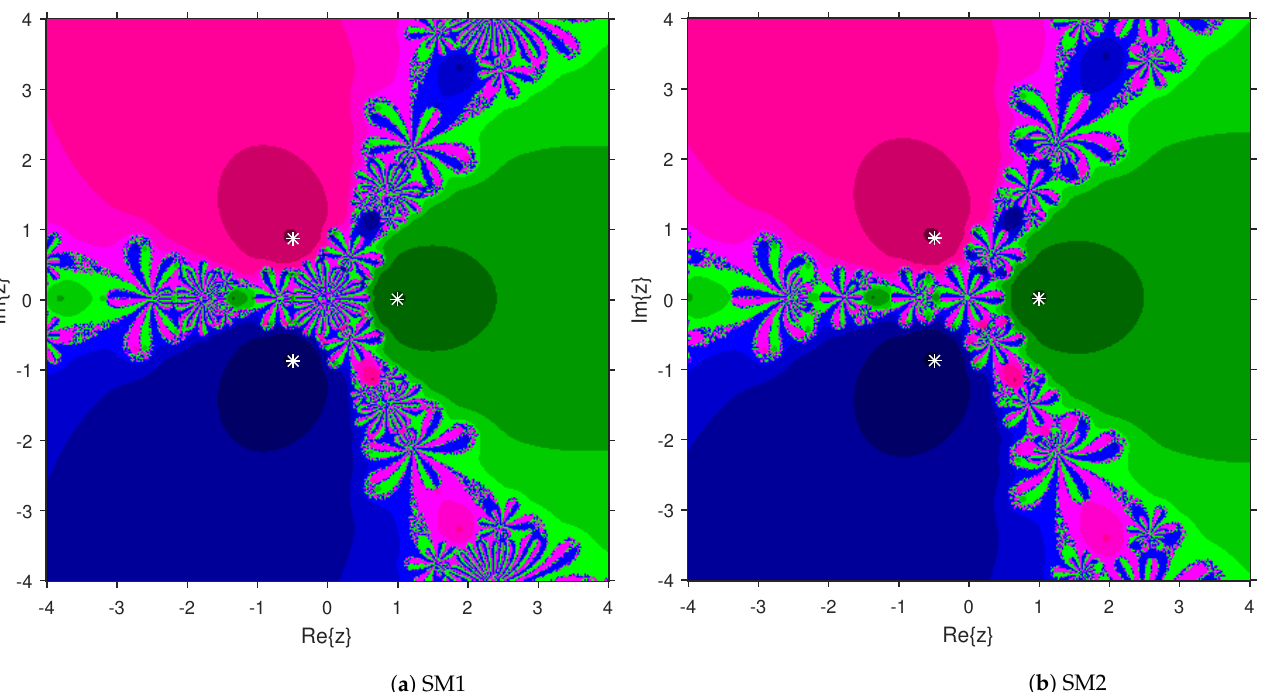
Figure 3. Attraction basins comparison between SM1 and SM2 related to M 3 ( z ) .